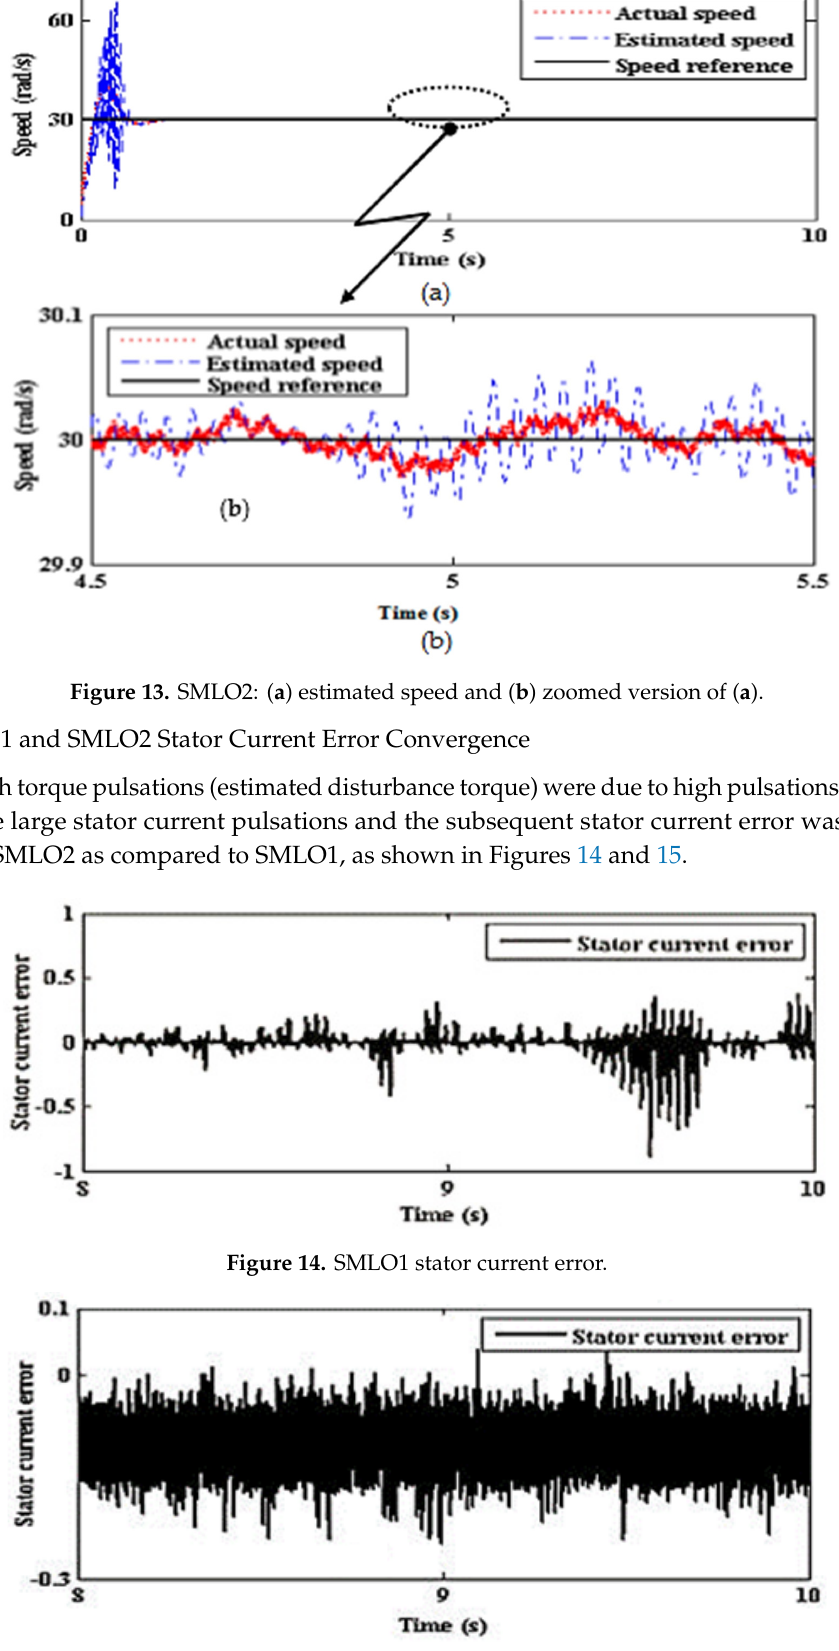
Figure 15. SMLO2 stator current error.